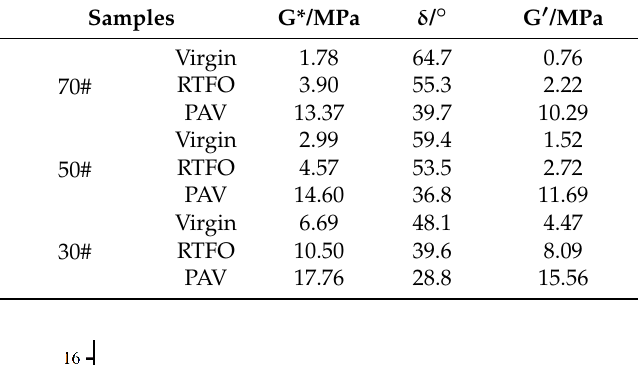
Table 8. Viscoelastic properties of asphalt before and after aging at 20 ◦ C.